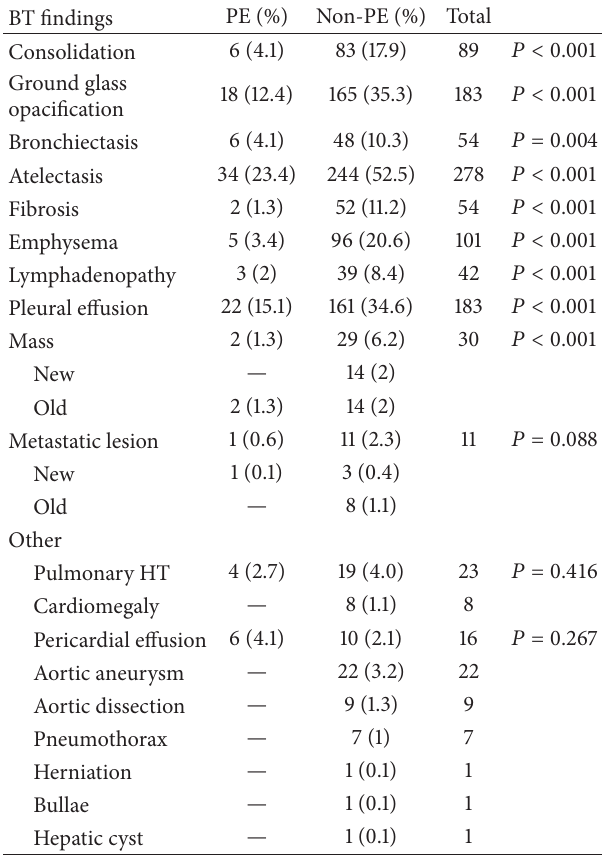
Table 5: CT findings and frequencies in PE and non-PE patients.